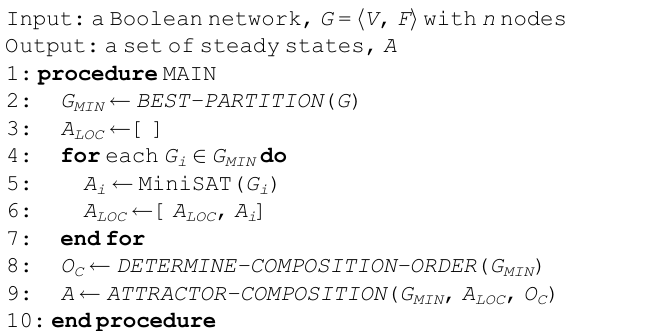
Algorithm 4 Pseudocode for the overall steady-state identification